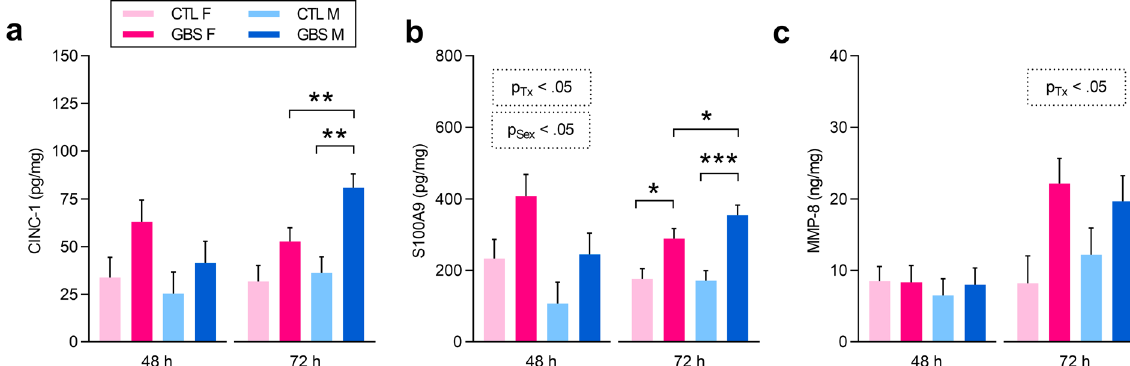
Figure 3. GBS-induced acute chorioamnionitis is associated with sex-specific placental levels of CINC-1 and S100A9 and increased MMP-8 production. ( a – c ) Mean placental concentrations of CINC-1/CXCL1 ( a ), S100A9 ( b ) and MMP-8 ( c ) detected by ELISA at 48 and 72 h post-injection. Analyses were done by linear mixed model and significant results are shown in the dashed box. Sidak’s multiple comparisons were used when the interaction between sex and treatment was significant. * P < 0.05, ** P < 0.01, *** P < 0.001. Bars represent mean ± SEM. Number (n) of placentas: n = 4 [48 h] and n = 6 [72 h] per sex in the GBS group, and n = 5 [48 h] and n = 5 [72 h] per sex in the CTL group. One male and one female placentas were used per